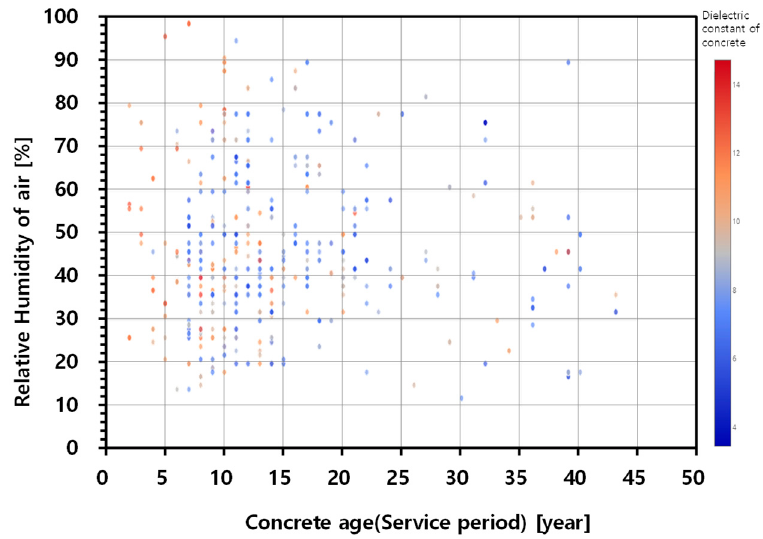
Figure 4. Two-dimensional image representing the distribution of dielectric constant of asphalt-covered bridge decks with relative humidity of air and concrete age (service period).